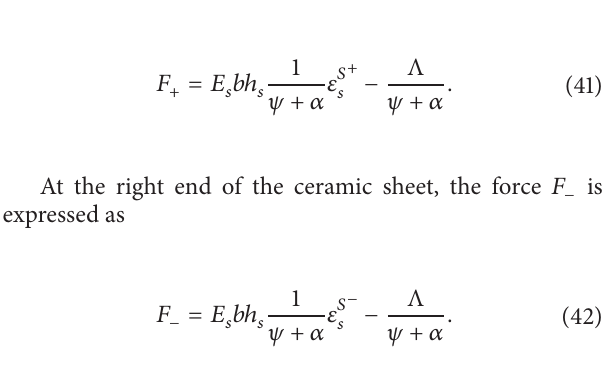
Figure 3: The second-order vibration curve of the vibrator with the PZT pasted in the center of the substrate.